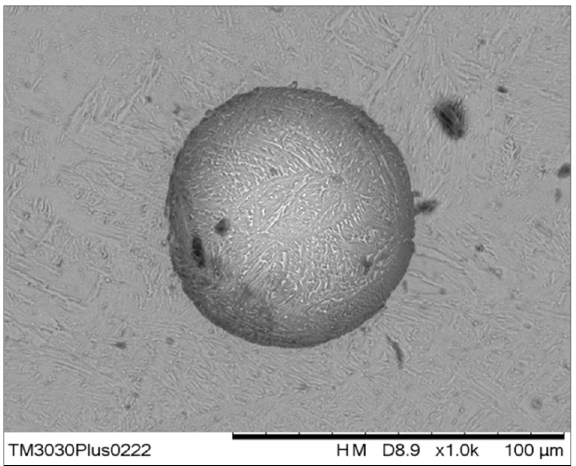
Optical macrographs of top surface (specimens A): ( a ) As-built; ( b ) Smoothed by manual grinding.